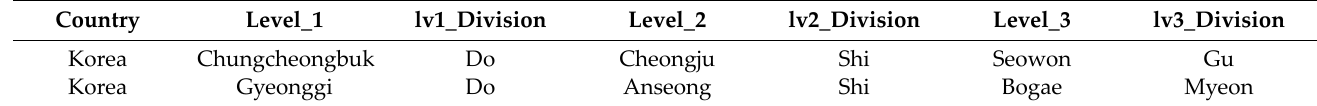
Table 1. Administrative district sample dataset (Korea).